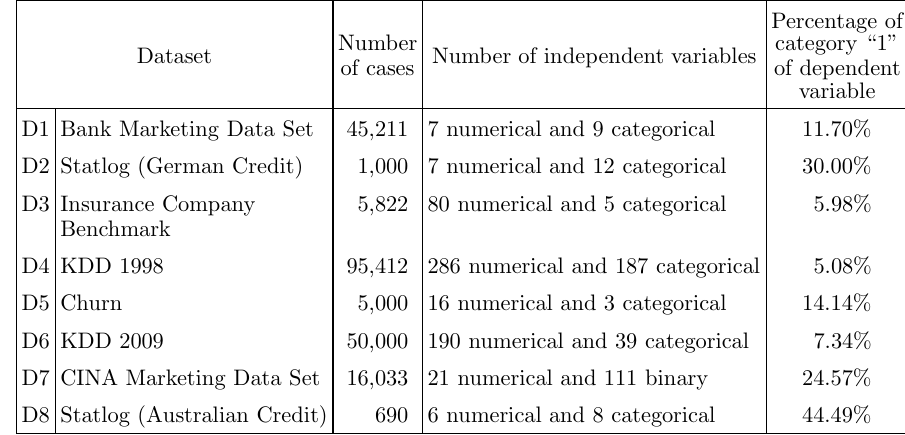
Characteristics of datasets applied in